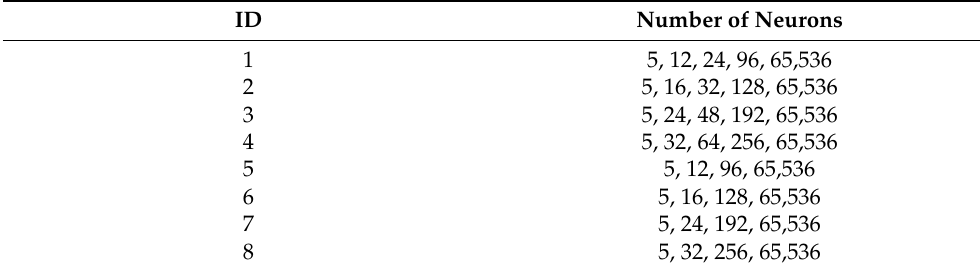
Table 2. The setting of the number of neurons in each layer for PWP-in. ID Number of